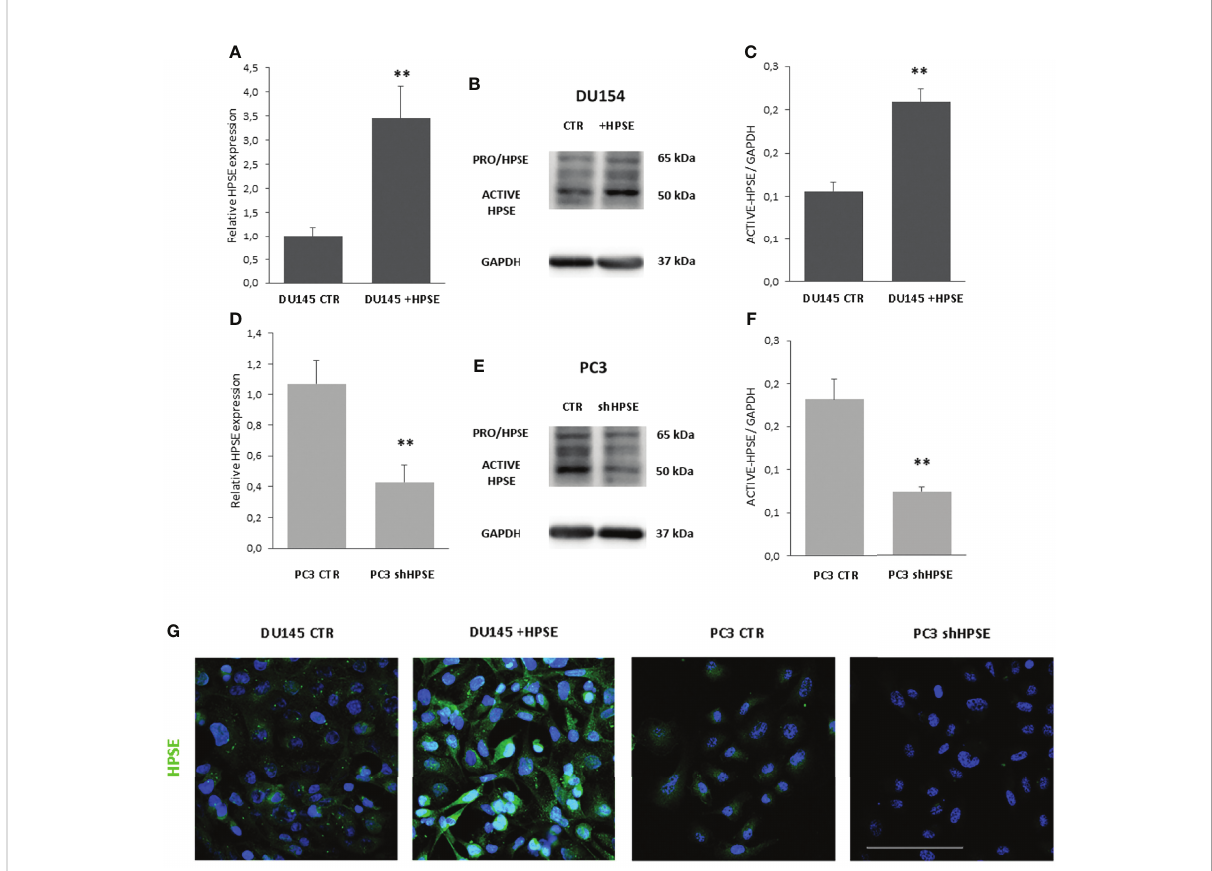
FIGURE 1 HPSE overexpression and silencing in prostate cancer cells. HPSE gene expression was evaluated by real-time PCR on DU145 (A) and PC3 (D) cells. Data were normalized to GAPDH expression. Means ± SD (error bars), n=6. **p < 0.001 vs. CTR. WB analysis of HPSE in DU145 (B) and PC3 (E) and relative quanti fi cation (C, F) . (G) HPSE immuno fl uorescence in DU145 and PC3 cells (green). Nuclei were counterstained with Hoechst 33342. Scale bar = 100 m